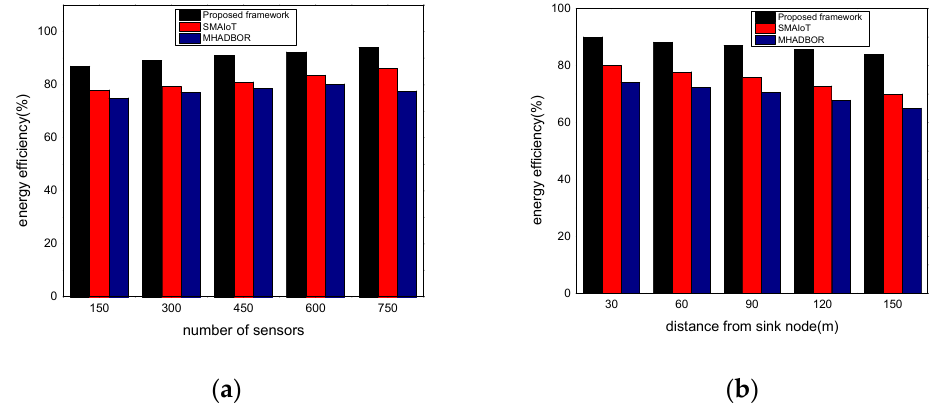
Figure 8. ( a ) Energy efficiency with varying sensors and ( b ) Energy efficiency with varying dis- tance.